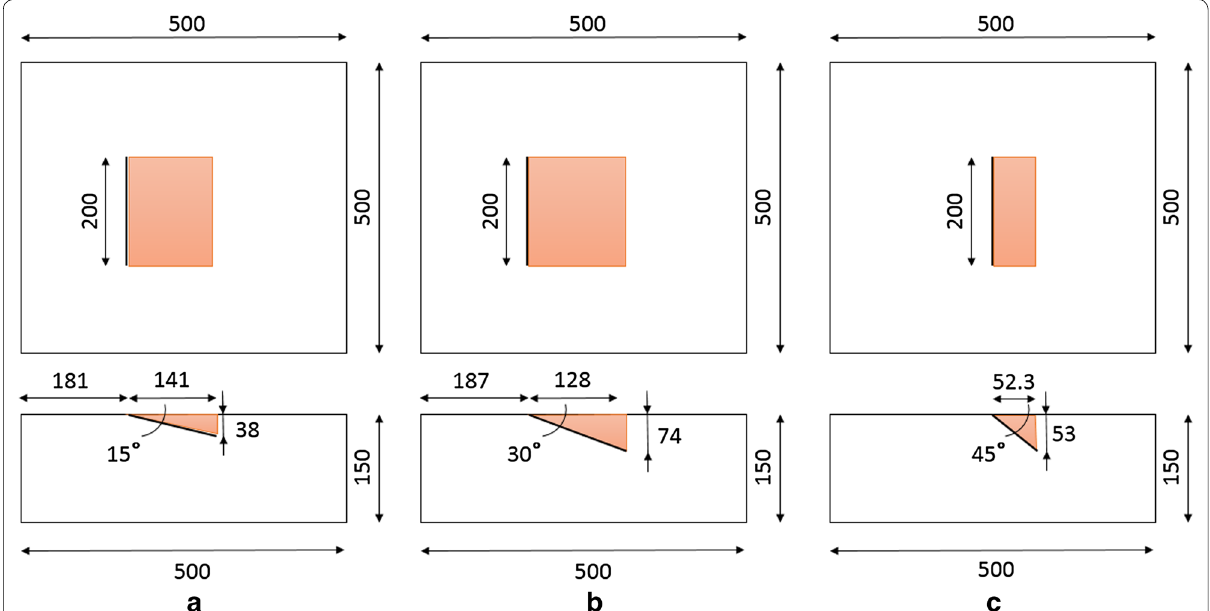
Fig. 6 Schematics of the test blocks used for the delamination detection experiments, these blocks present crack of various inclination from the surface: a 15°, b 30° and c 45°. It is worth noticing that these defects were man-made with the intention to closely reproduce field-found delamina- tions (dimensions specified in